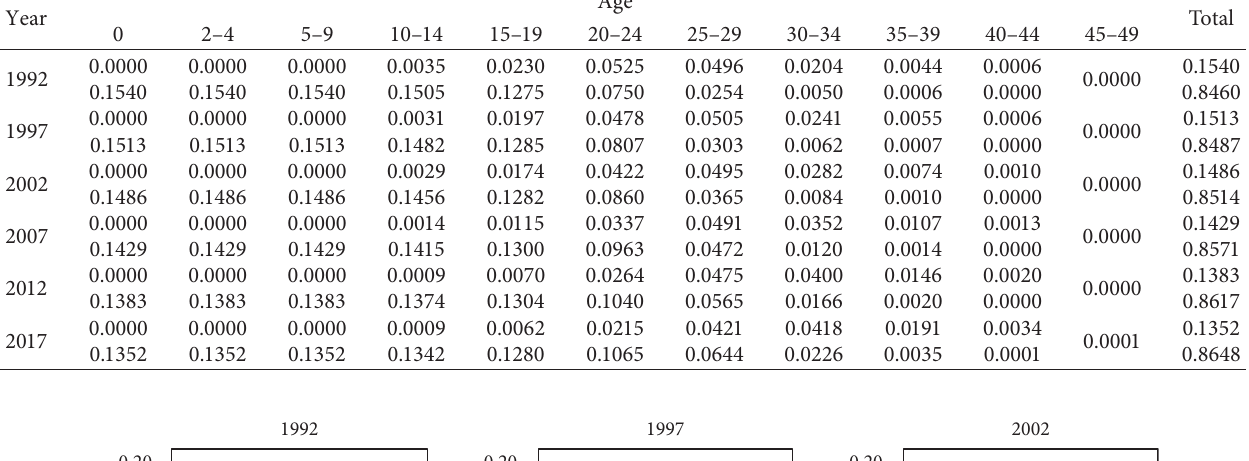
Table 4: Elasticity matrices with the first row and subdiagonal elements (1992–2017).